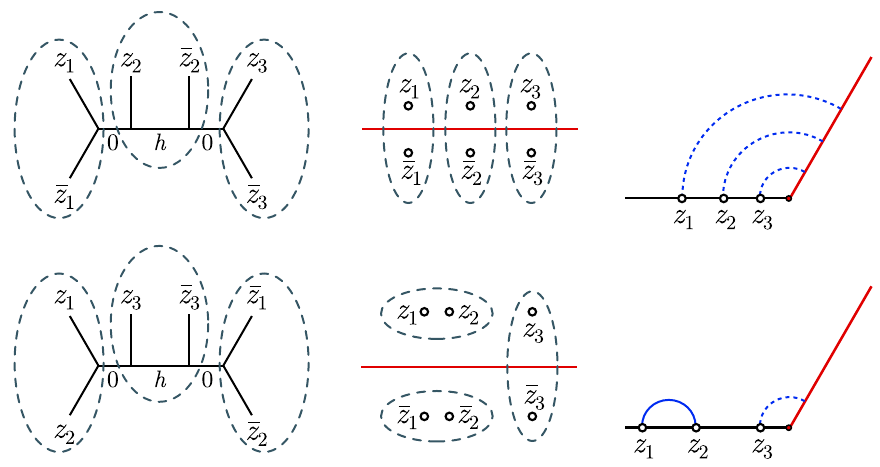
Figure 9 . Left. Vacuum exchange in two different channels for k = 3 twists on the UHP. Trivial cycles cut through identities. Middle. The monodromy cycles to be trivialized in the doubled picture of the BCFT. Right. The corresponding RT topologies in the bulk with an ETW